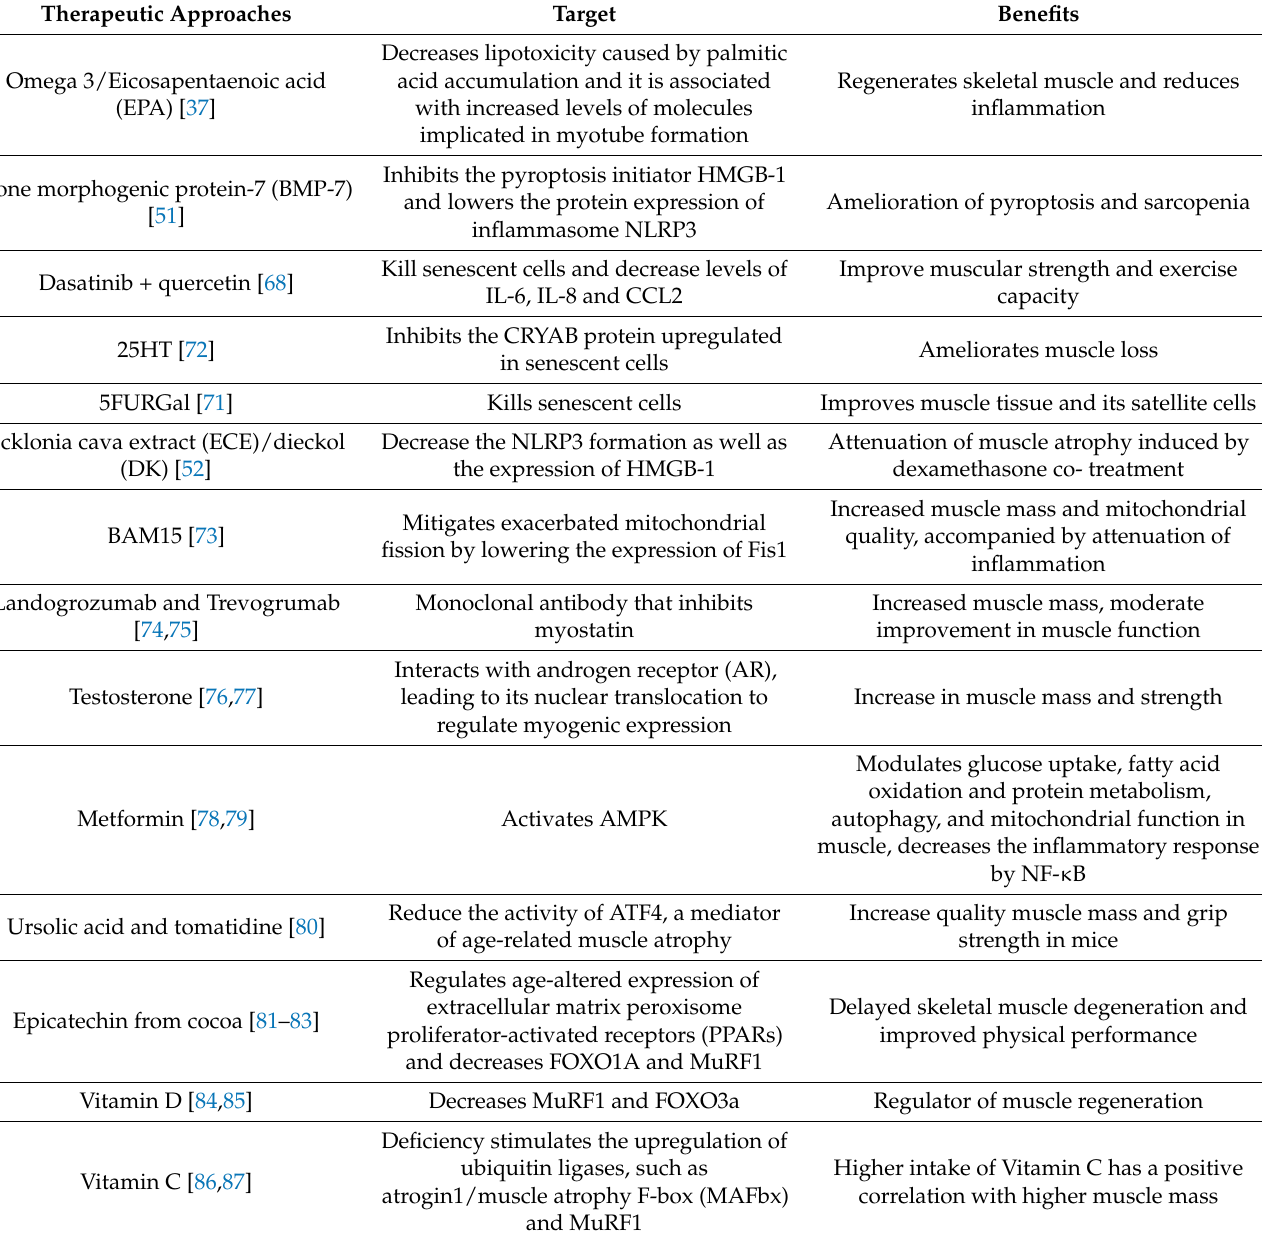
Table 1. The summary table of new therapeutic agents proposed to treat sarcopenia and muscle